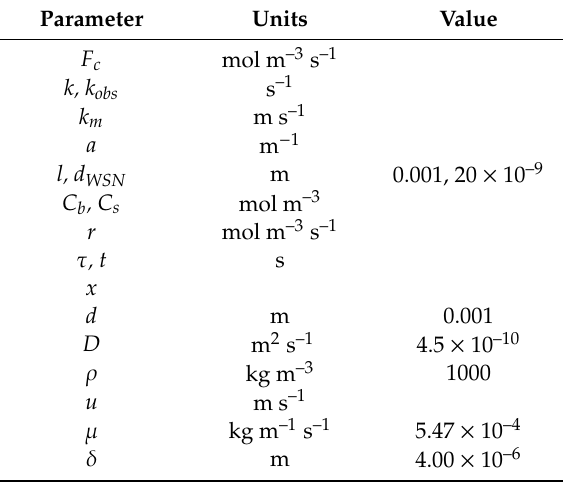
Table 3. Parameters used to calculate mass transfer